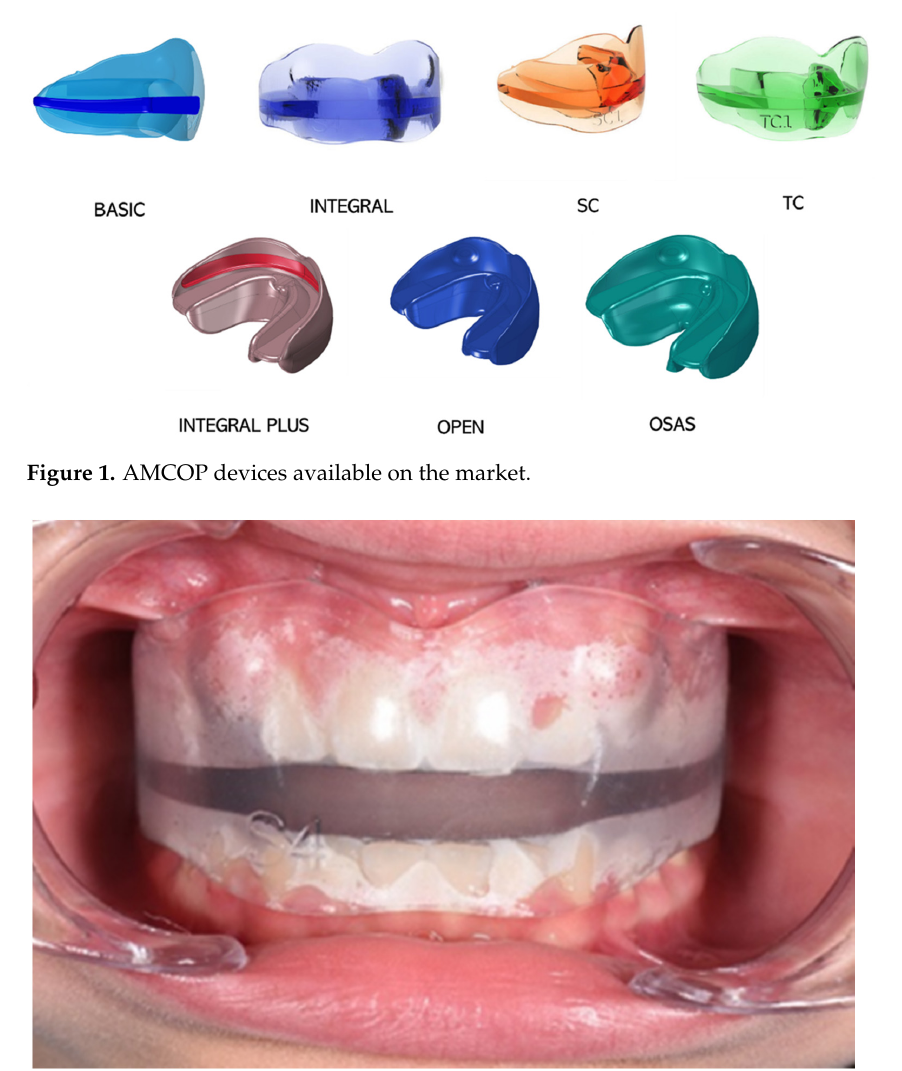
Figure 2. Intraoral photo of the AMCOP INTEGRAL device which presents a flat occlusal plane for class I